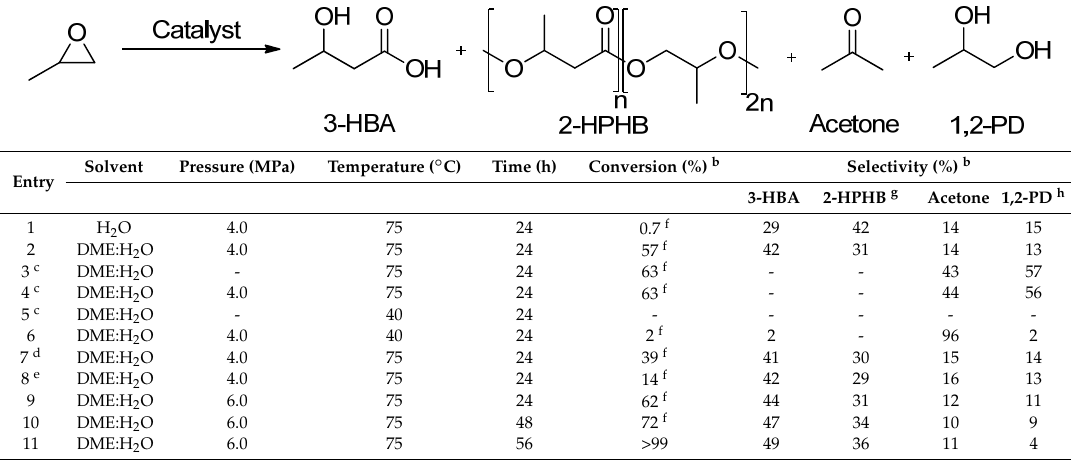
Table 1. Catalytic ring-opening carbonylation of PO using [Bmim][Co(CO) 4 ] complex and imidazole as a promotor a .